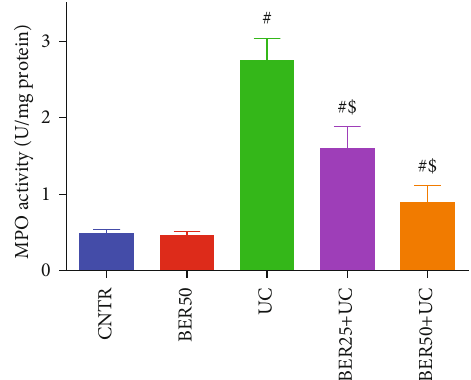
Figure 7: E ff ect of berberine at di ff erent doses on MPO activity in colonic tissue of experimental colitis in rats. The results are expressed as the mean ± SD ( n = 7 ). # p < 0 : 05 compared to the CNTR group (intact group); $ p < 0 : 05 compared to UC-untreated